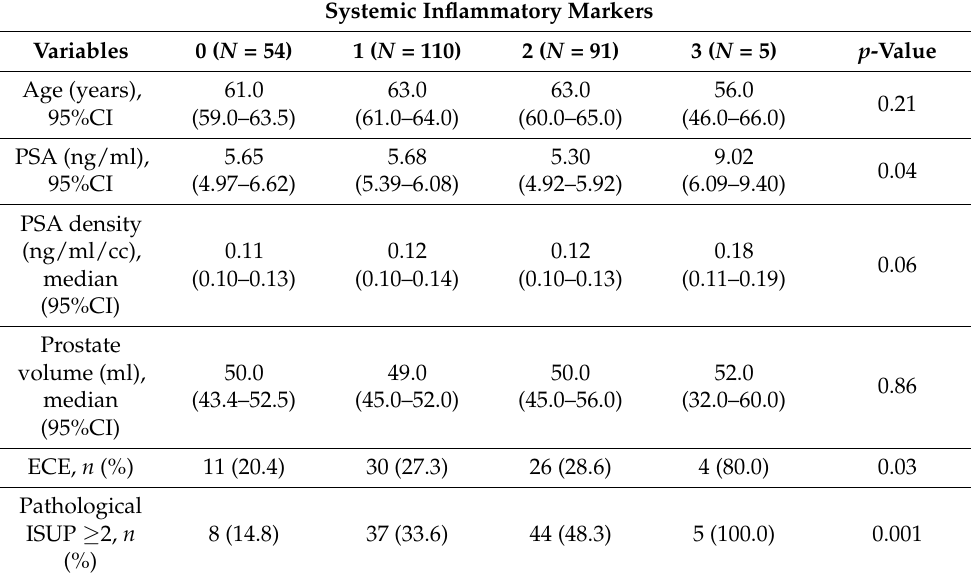
Table 3. Association of baseline clinicopathologic characteristics and number of cumulative marker score in the total cohort.